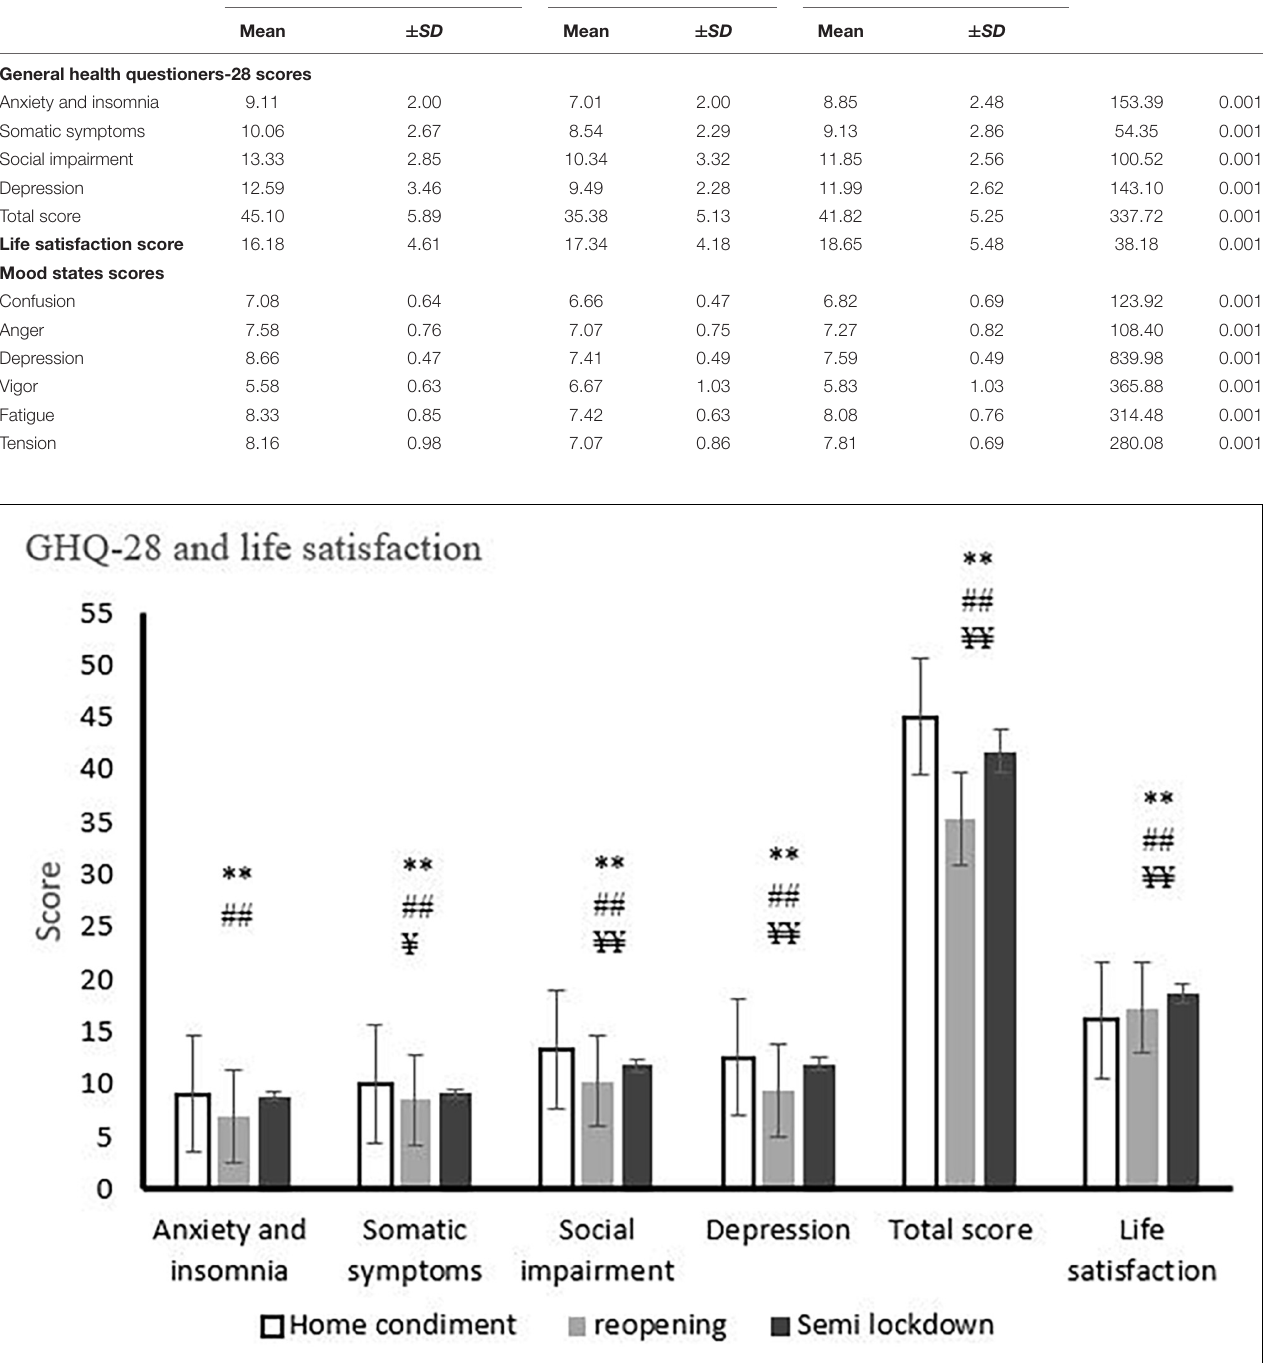
FIGURE 1 | General health questionnaire-28 subscales and life satisfaction during phases of home confinement, reopening, and semi-lockdown conditions. * p < 0.05 (between home confinement condition and reopening condition), ** p < 0.01 (between home confinement condition and reopening condition), # p < 0.05 (between home confinement condition and semi-lockdown condition), ## p < 0.01 (between home confinement condition and semi-lockdown condition), (cid:85) p < 0.05 (between reopening condition and semi-lockdown condition), (cid:85)(cid:85) p < 0.01 (between reopening condition and semi-lockdown condition). Each column represents the mean ratings ± S.E. (standard